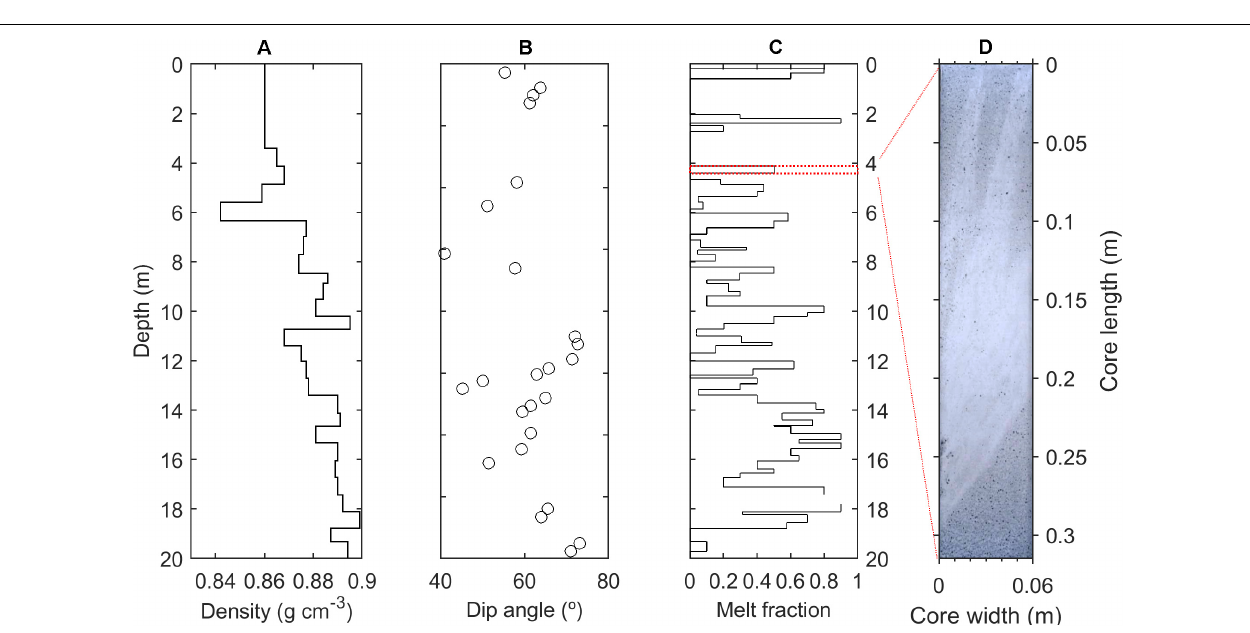
FIGURE 7 | Visual stratigraphy for the top 20 m of the ice core. (A) Density; (B) dip angles of melt features; (C) melt fraction; the red rectangle shows the location of the core shown in (D) ; (D) example of melt feature reminiscent of penitent morphology.